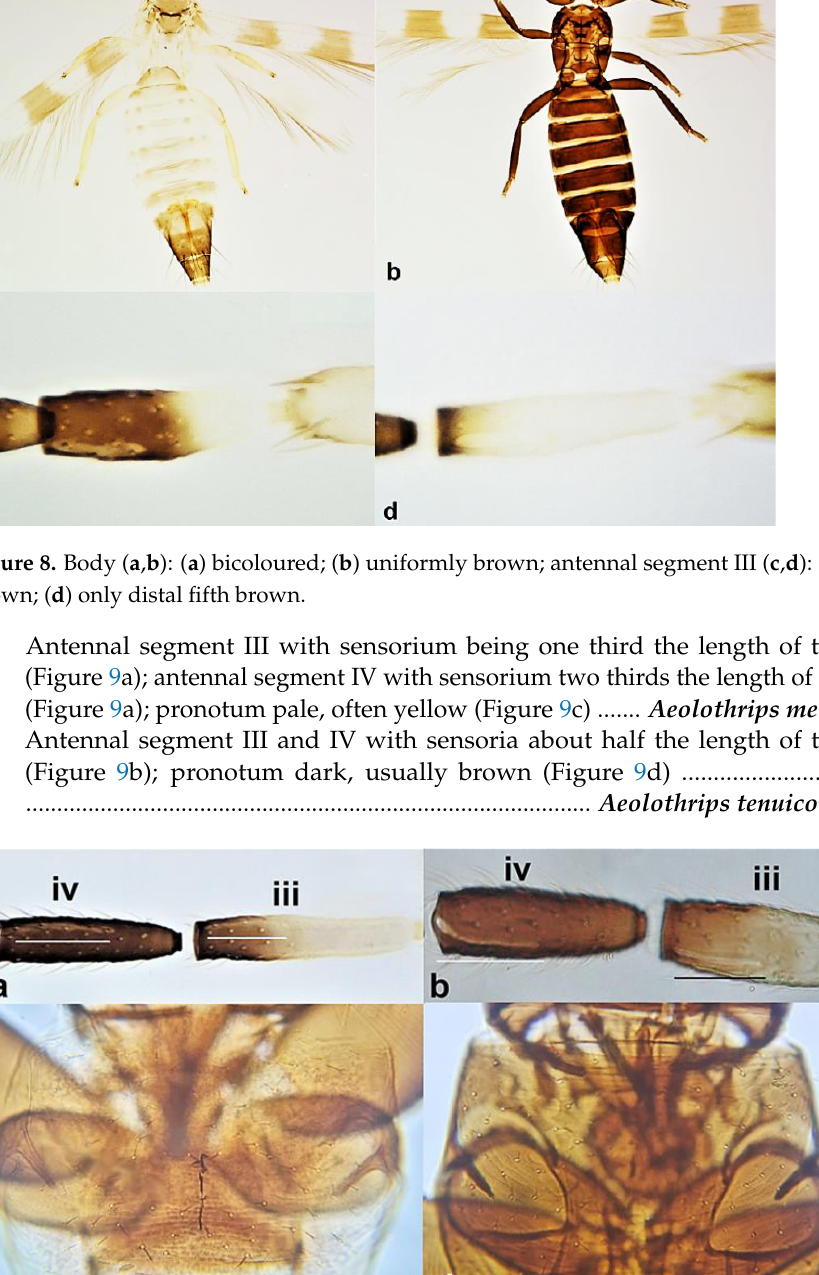
Body bicoloured, with head and thorax yellow with brown areas medially (Figure 8a); antennal segment III bicoloured, with the basal half of segment pale yellow, while the apical half dark brown (Figure 8c) ................................. Aeolothrips gloriosus Bagnall Body uniformly dark brown, though upper abdominal segments can sometimes be lighter coloured (Figure 8b); antennal segment III yellow or yellowish brown with the distal fifth brown, paler than segment II (Figure 8d) ..........................................................